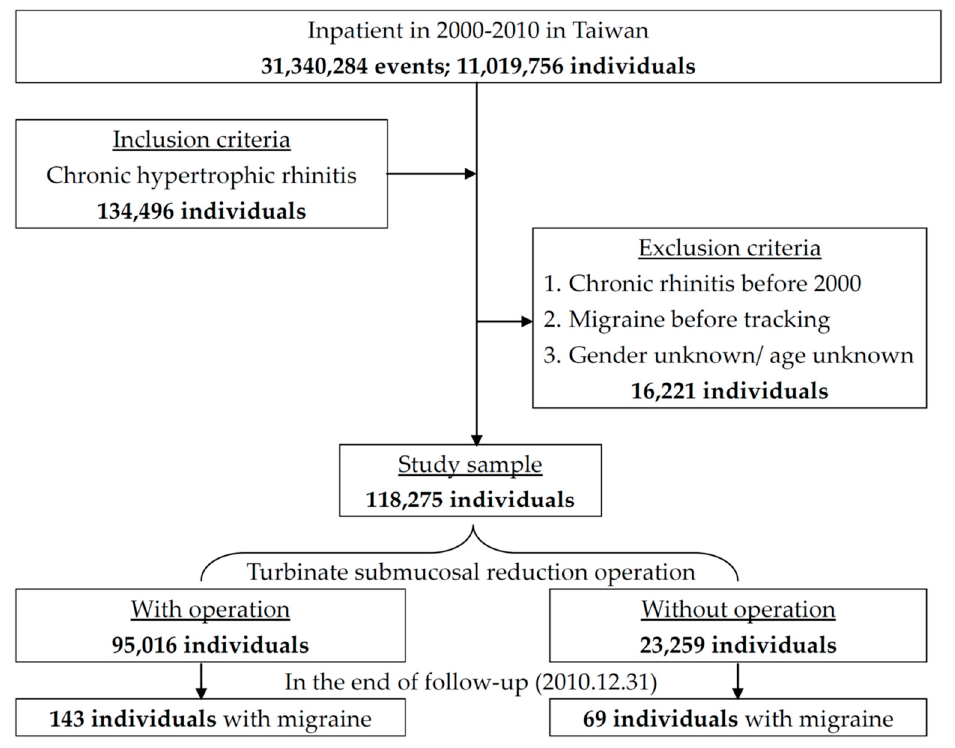
Figure 1. Flow chart of this study.